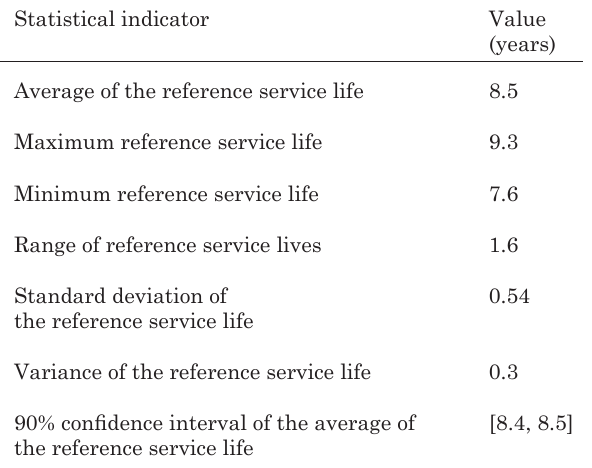
Table 10. Summary of the statistical indicators for the reference service life, estimated using the